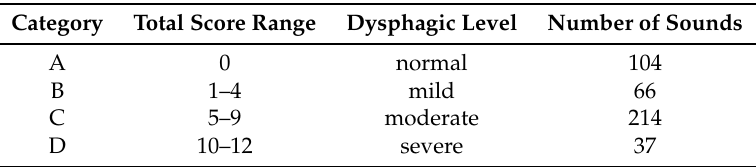
Table 1. Definition of dysphagia classification categories derived from scoring based on the method proposed by Hyodo et al. [19] using the VE swallowing test.